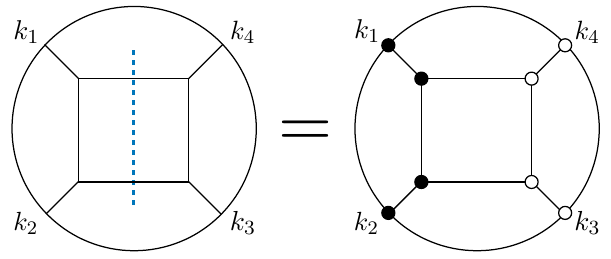
Figure 1 . The map from the cutting to coloring rules for the AdS box